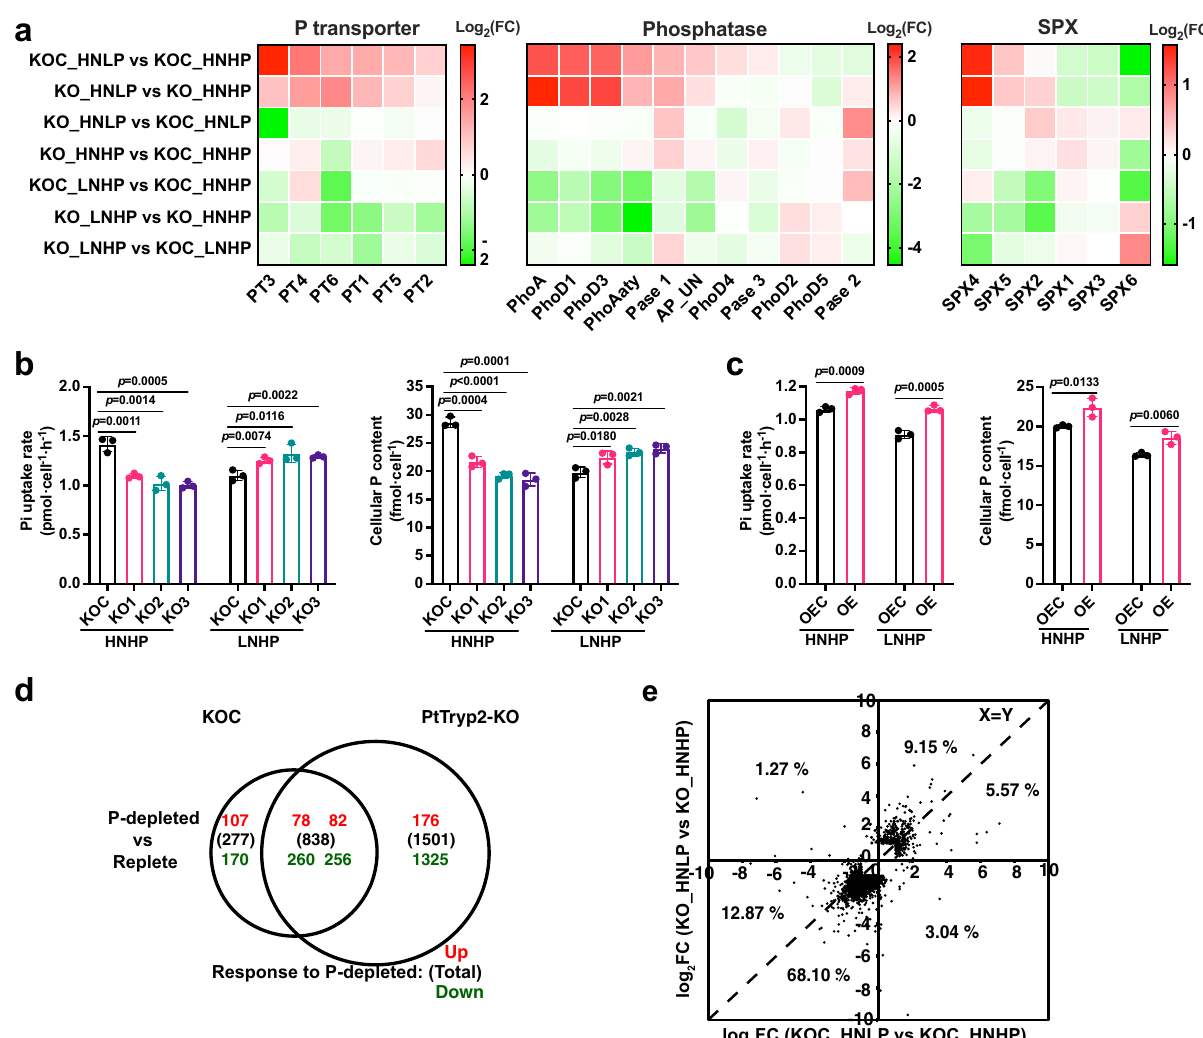
Fig. 6 Transcriptomic and physiological evidence that PtTryp2 positively modulates P starvation-induced genes during Pi starvation. a PtTryp2 knockout resulted in a reverse regulation of most P starvation-induced genes relative to that in control (KOC) under N-depleted (LNHP), P-depleted (HNLP), and nutrient-replete (HNHP) conditions. b PtTryp2 knockout caused decreases in Pi uptake and cellular P content under nutrient-replete condition (HNHP) but caused increases under N-depleted condition (LNHP). Data are presented as mean values± SD ( n = 3 biologically independent samples). The comparisons between the averages of the two groups were evaluated using the one-tailed Student ’ s t test. The p values with signi fi cance ( p ≤ 0.05) are shown. c PtTryp2 knockout caused increases in Pi uptake rate and cellular P content under HNHP and LNHP. Data are presented as mean values± SD ( n = 3 biologically independent samples). The comparisons between the averages of the two groups were evaluated using the one-tailed Student ’ s t test. The p values with signi fi cance ( p ≤ 0.05) are shown. d Venn diagram showing the number of P-depletion induced DEGs in PtTryp2 -KO1 and KOC. In parentheses, total number of DEGs; red font, upregulated; green font, downregulated. e Log 2 fold changes (FC) of P-depletion induced differential gene expression in PtTryp2 -KO1 against that in KOC. Most data points (95.69%) are distributed in 1,3 quadrants, indicating the same direction of change. Source data are provided as a Source Data fi